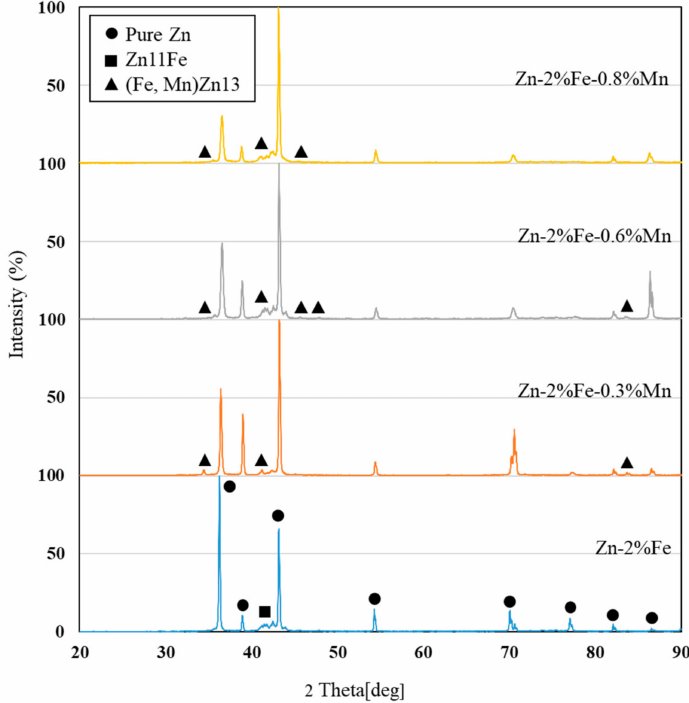
Figure 1. X-ray analysis of Zn-2%Fe alloys with up to 0.8%Mn. Typical microstructure, as derived by optical microscopy of Zn-2%Fe alloys with up to 0.8% Mn post extrusion process, is shown in Figure 2. This reveals a finer homogenized microstructure with some degree of preferred orientation post extrusion, as expected. SEM examination of the alloy with the highest content of Mn (0.8%) post extrusion is